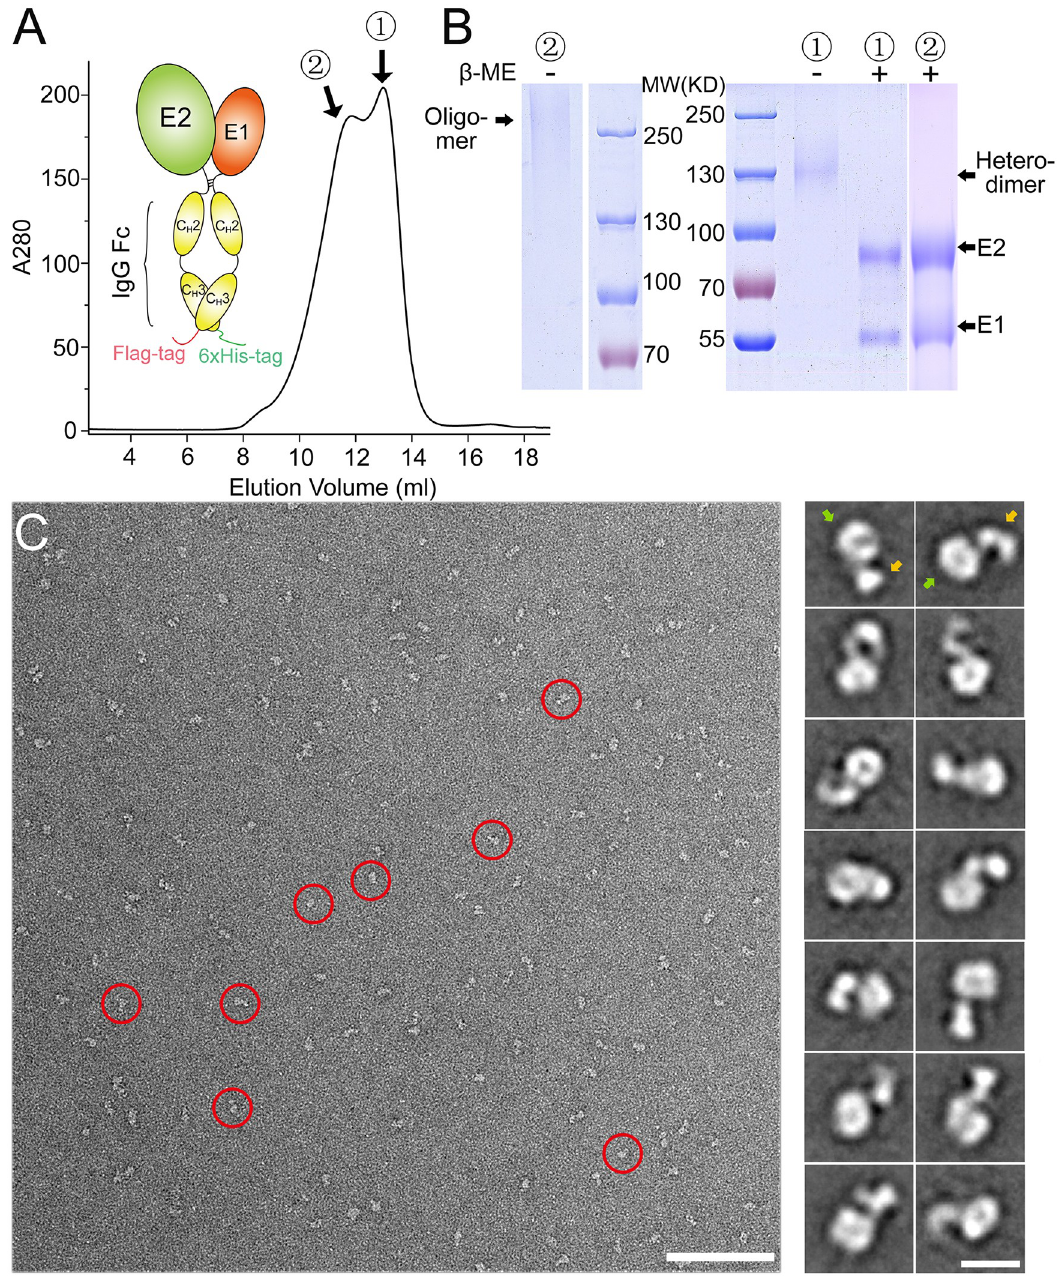
Fig 1. Expression of HCV E1E2 as an Fc-tagged heterodimer in insect cells. (A) Schematic representation of the Fc-tagged HCV E1E2 heterodimer and the SEC profile of the purified E1E2-Fc. The heterodimeric and oligomeric peaks of E1E2-Fc are labeled as 1 and 2, respectively. (B) SDS-PAGE of the purified E1E2-Fc under reducing and non-reducing conditions for the two peaks shown in (A). (C) A negative staining EM image showing the heterodimeric E1E2-Fc particles (left; red circles; bar, 100 nm). The representative 2D averaging classes are also shown (right; bar, 10 nm). The head and the tail regions are indicated by green and orange arrows, respectively.